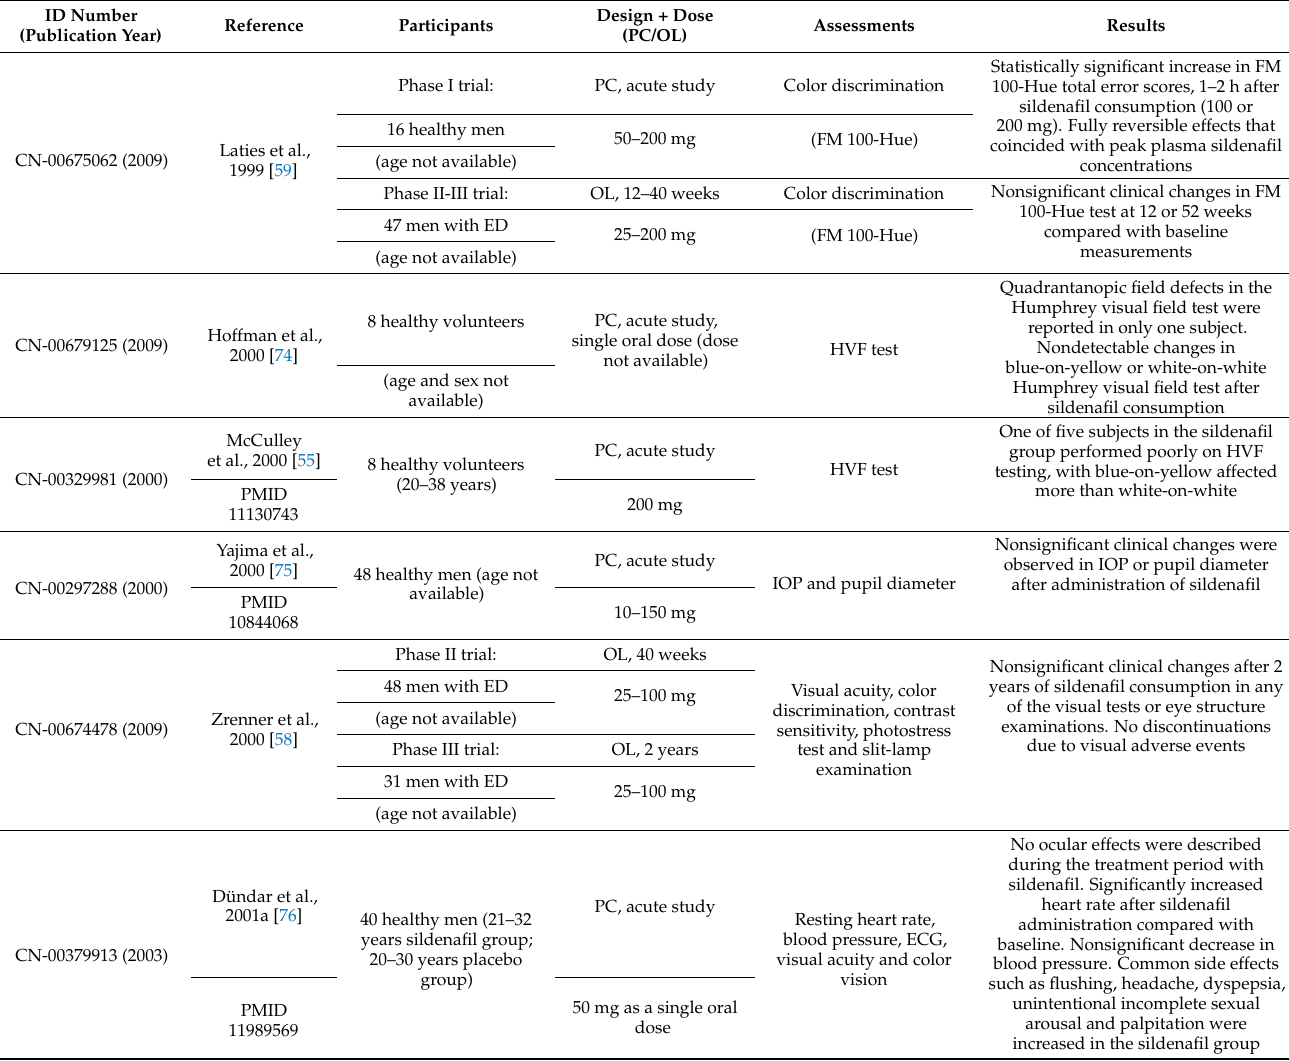
Figure 2. Classification of clinical trials that assess sildenafil effects on visual health according to: ( a ) year of publication (frequency histogram); ( b ) medical condition (pie chart; results are disaggregated by gender). ED, erectile dysfunction; AMD, age-related macular degeneration; COAG, chronic open-angle glaucoma; PAH, pulmonary arterial hypertension; IS, ischemic stroke. Table 3. Summary of studies designed to assess the effects of sildenafil on vision.